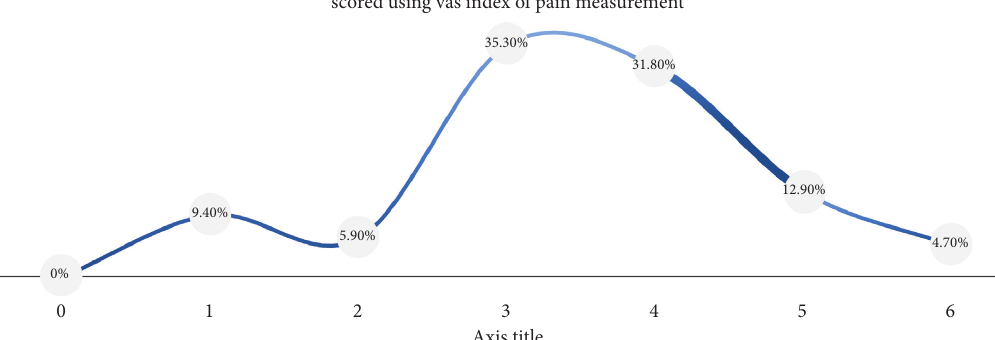
Figure 7: The pain (burning sensation) scores taken between the recorded sessions using Er,Cr: YSGG